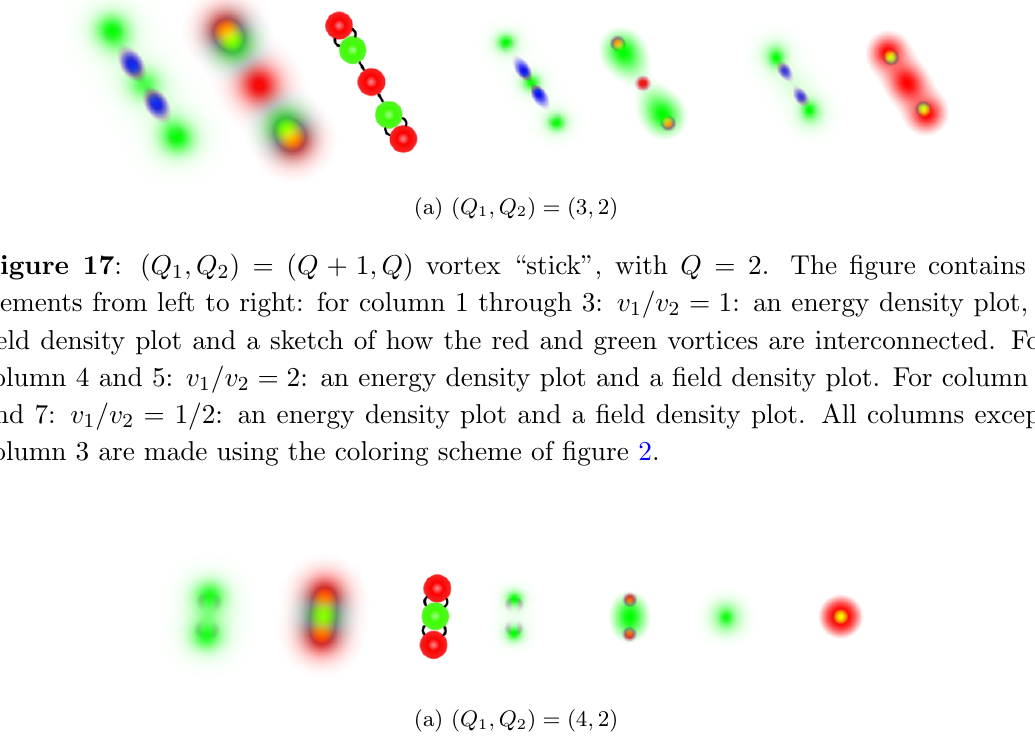
Figure 18 : ( Q 1 ; Q 2 ) = (2 Q; Q ) minimal vortex \pill", with Q = 2. The (cid:12)gure contains 7 elements from left to right: for column 1 through 3: v 1 =v 2 = 1: an energy density plot, a (cid:12)eld density plot and a sketch of how the red and green vortices are interconnected. For column 4 and 5: v 1 =v 2 = 2: an energy density plot and a (cid:12)eld density plot. For column 6 and 7: v 1 =v 2 = 1 = 2: an energy density plot and a (cid:12)eld density plot. All columns except column 3 are made using the coloring scheme of (cid:12)gure